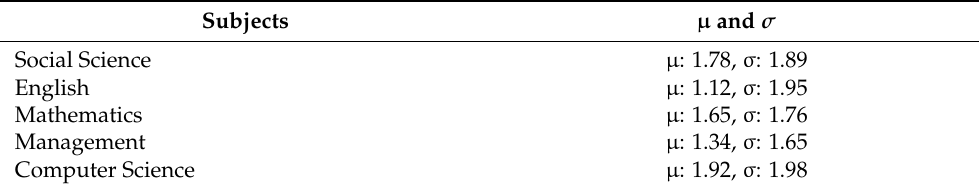
Table 2. µ and σ in different groups [7–14,18–20].